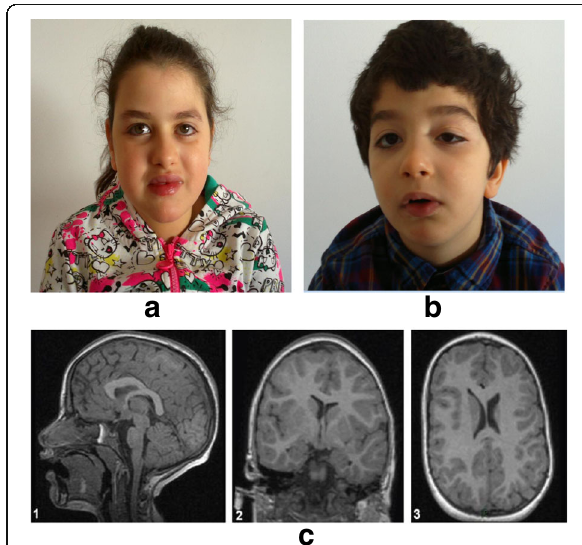
Fig. 1 a The proband . b the brother of the proband . c Proband ’ s MRI (1) sections showing dysmorphic and thick corpus callosum and (2, 3) the lateral ventricular